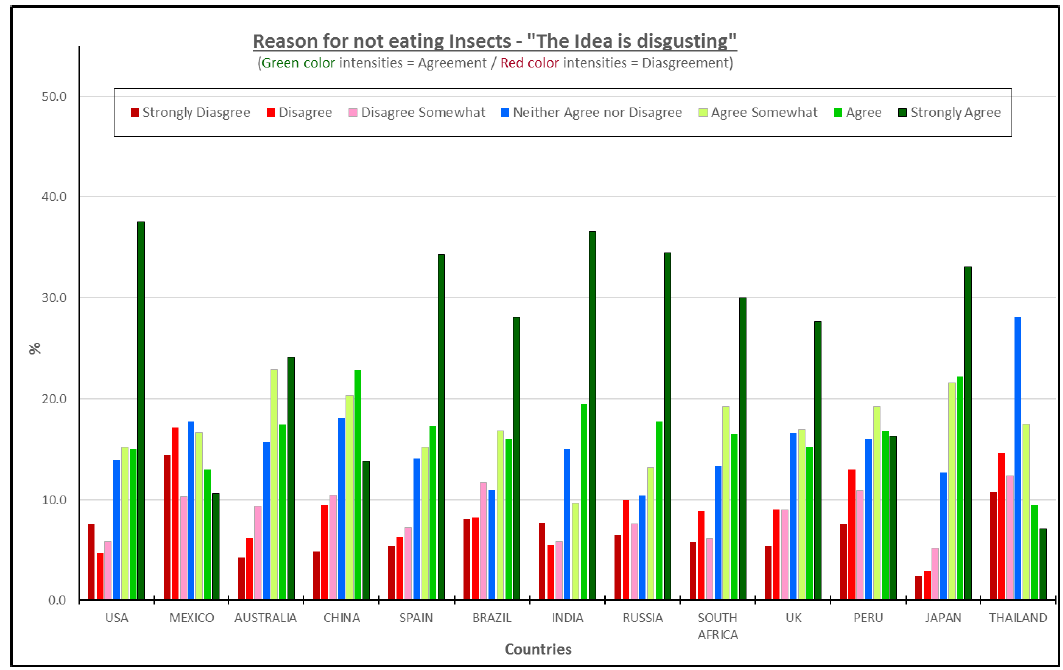
Figure 5. The reasons for not eating insect products—“The idea is disgusting”.